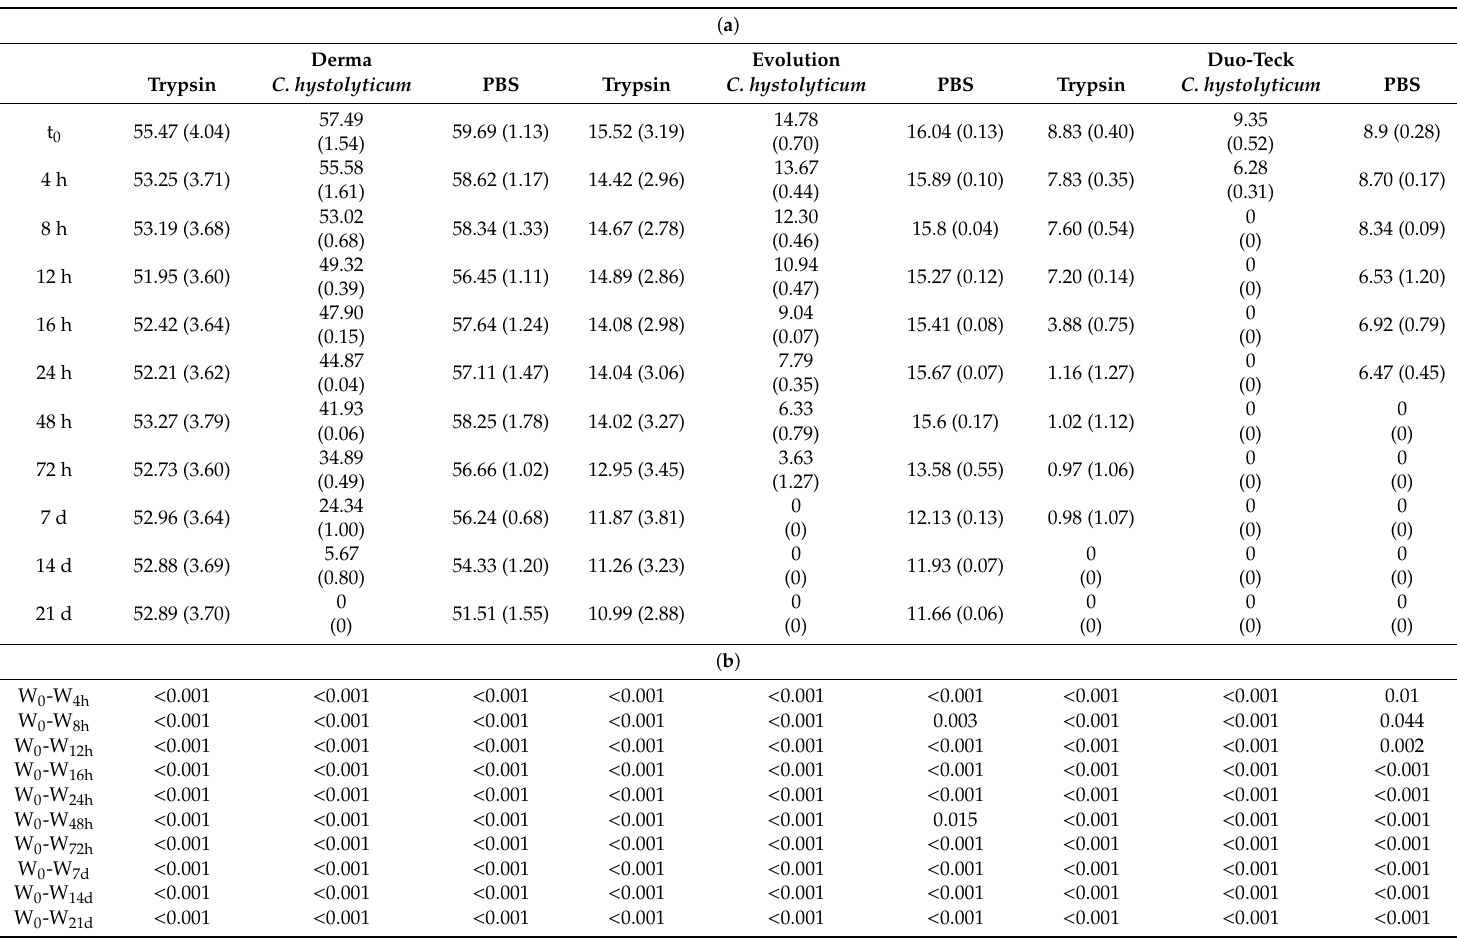
Table 2. ( a ) Weight ( µ g) analysis of the three experimental membranes (Derma Fina, Evolution Standard and Duo-Teck) after immersion periods up to 21 days in PBS (Hydrolytic degradation test), collagenase from Clostridium histolyticum (Bacterial collagenase resistance test) and trypsin (Enzyme resistance test). Values shown are mean and standard deviation. ( b ) Attained p values after pairwise comparisons between membranes’ weights after the di ff erent immersion times and the initial weight (weight at t 0 : W 0 ). Significance was considered at p ≤